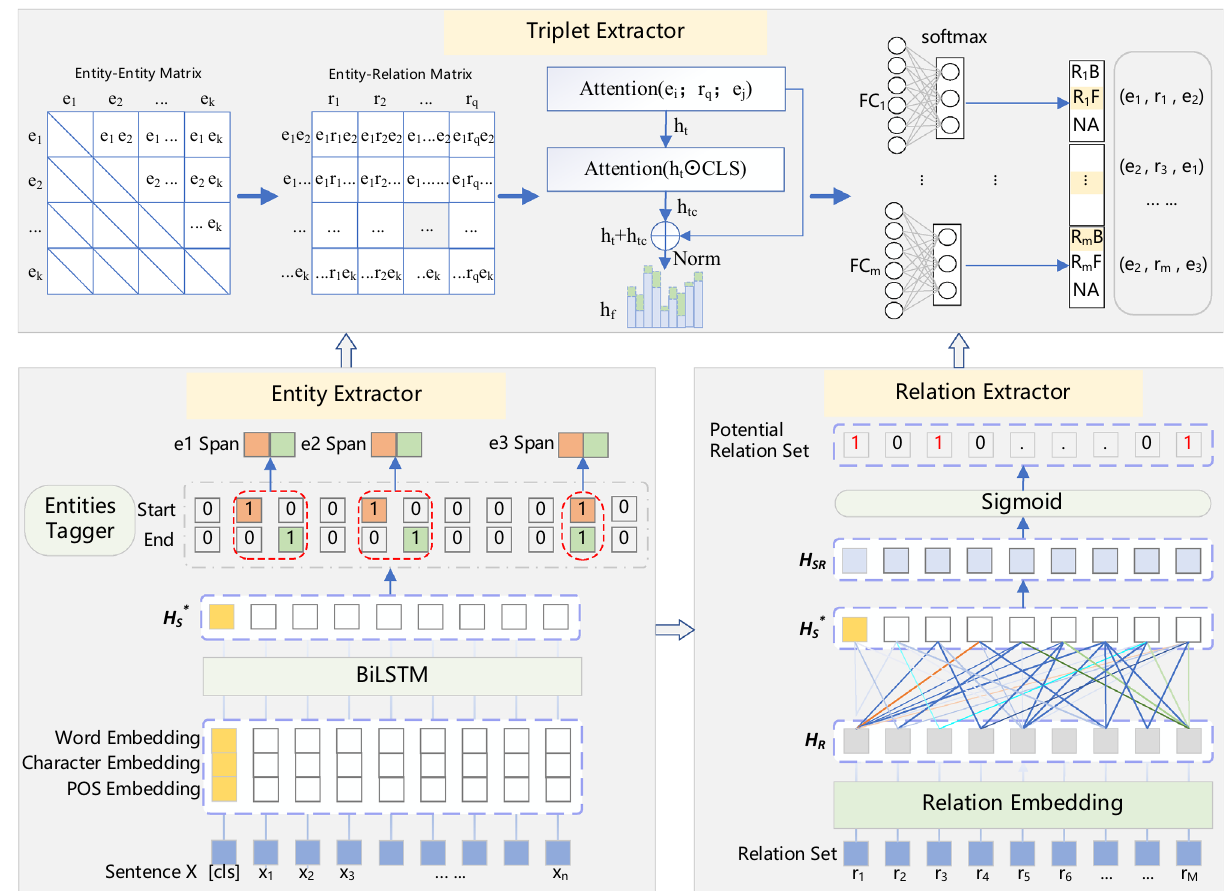
Figure 1. The framework of the proposed joint extraction